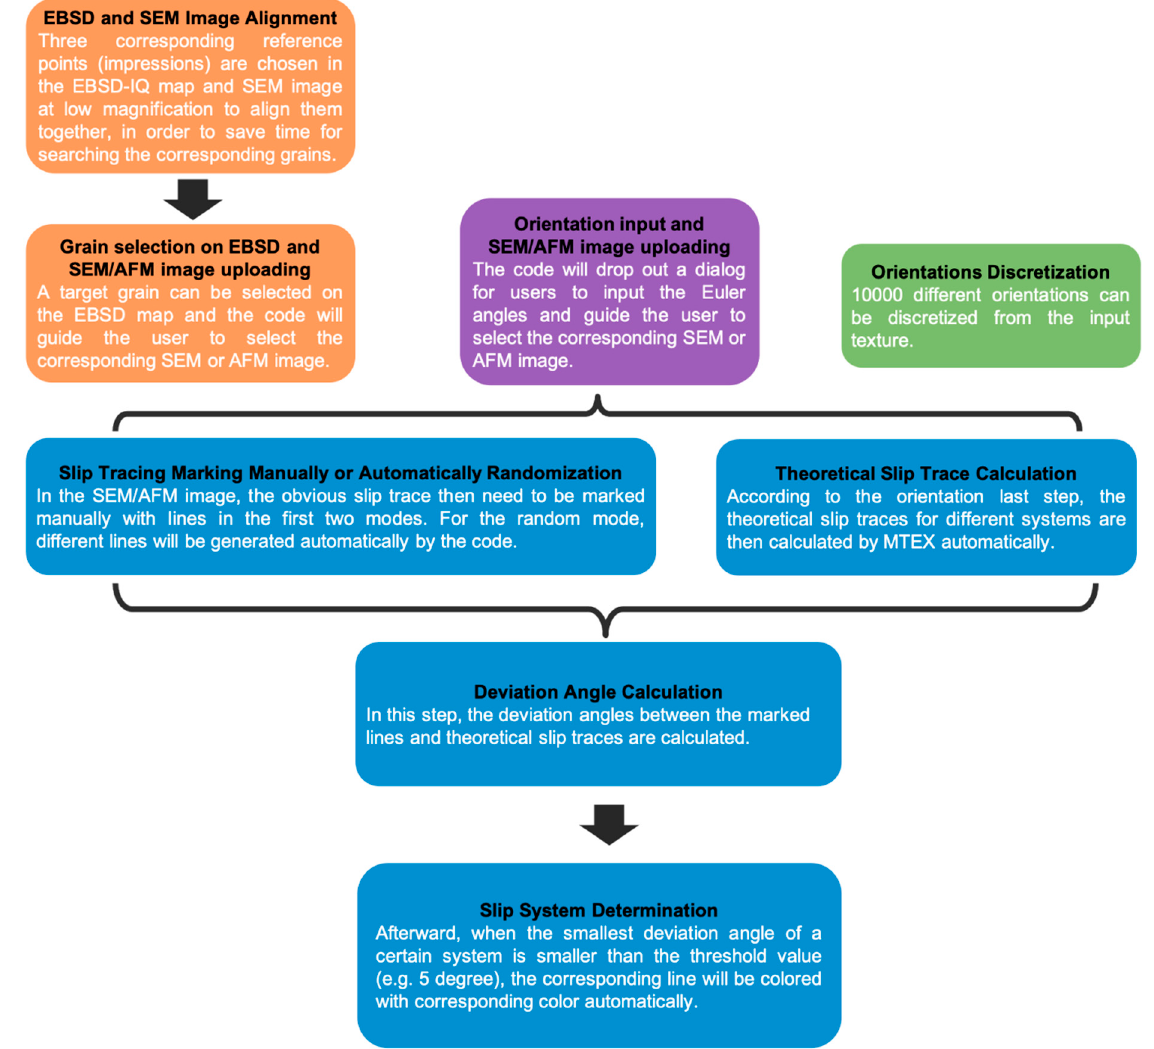
Figure 4. Workflow of the automated slip line analysis code. Orange segments show analysis steps corresponding to the input of EBSD maps (mode 1), purple shows mode 2 and green shows mode 3. All the blue segments then run to give the final assignment of a slip line to a slip system.